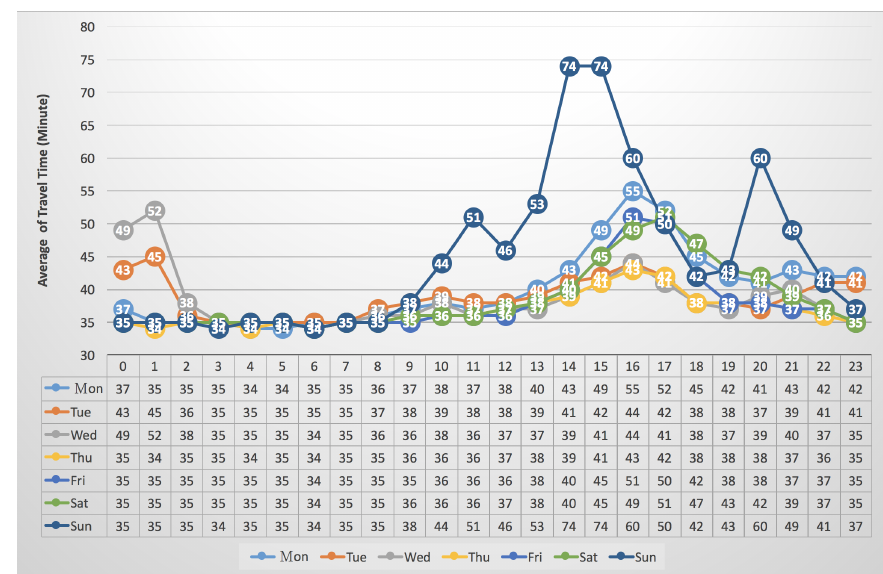
Figure 15. The average of travel time of vehicles in the northern (N) direction vs. “24 h per day” and “seven days per week”.